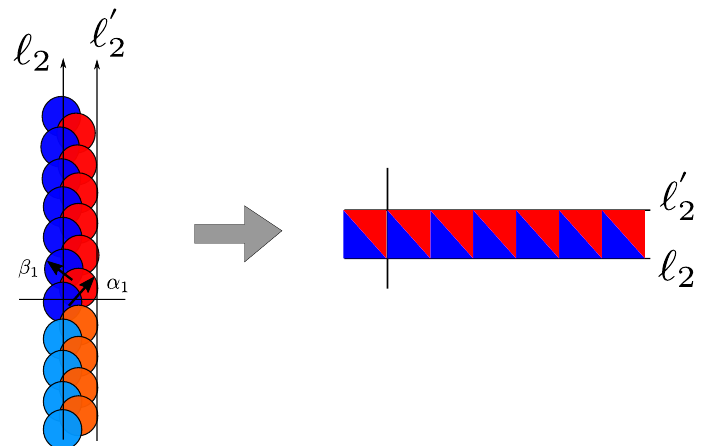
Figure 16. The one-dimensional crystal associated with ‘ 2 . The orange and light blue atoms are atoms originally not in the three-dimensional crystal but added to obtain the one-dimensional crystal. We can redraw this crystal as a sequence of boxes with blue and red triangles inside it.